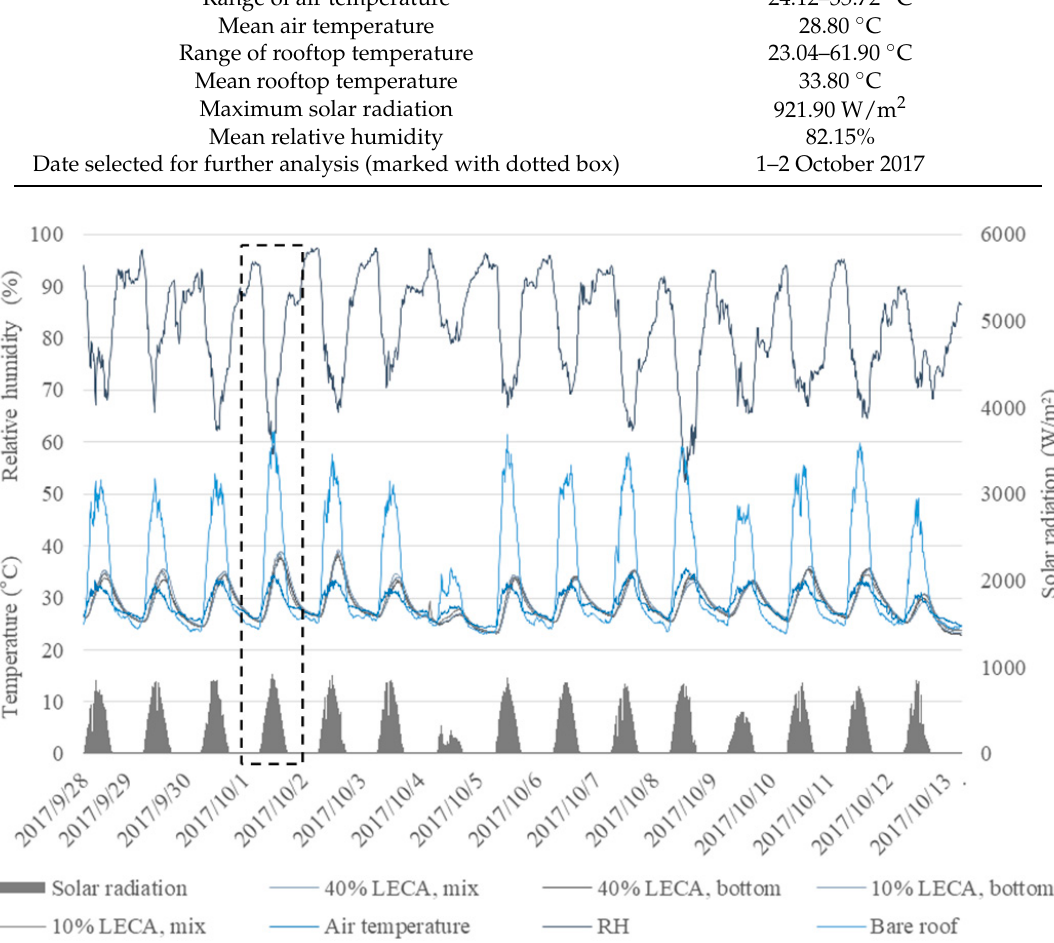
Figure 17. Temperatures, solar radiation, and relative humidity in the cases of roofs with 10% and 40% LECA laid at the bottom with Ipomoea batatas , and of 10% and 40% LECA mixed with soil with Ipomoea batatas (28 September 2017 06:07:57 to 13 October 2017 05:57:57).